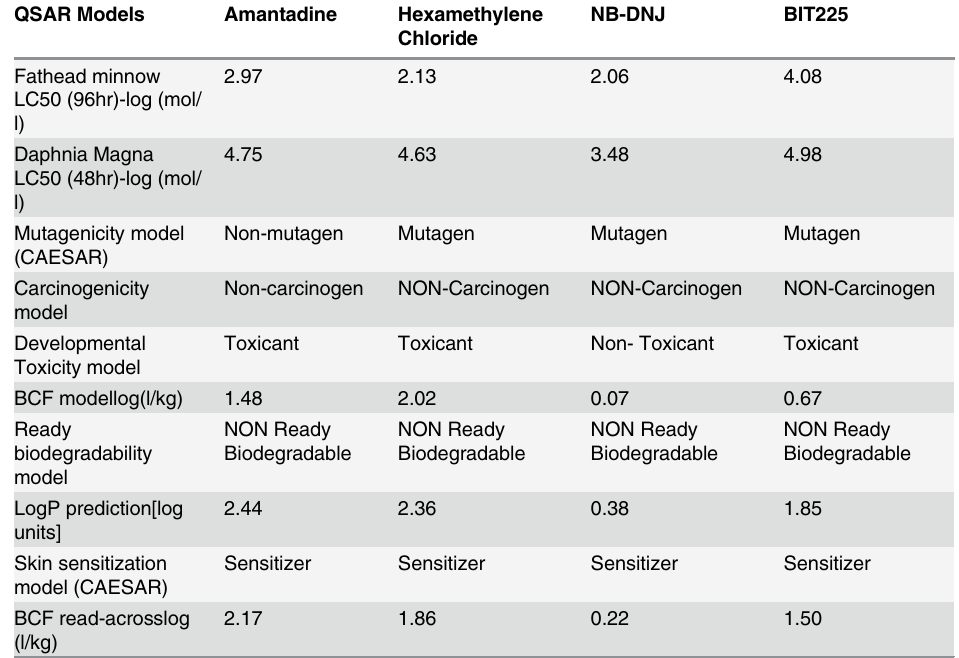
Table 4. Predicted values for the selected drugs using VEGA QSAR and their applicability domain analysis for various models. QSAR